Question: Looking at the figure, what chart type is it?
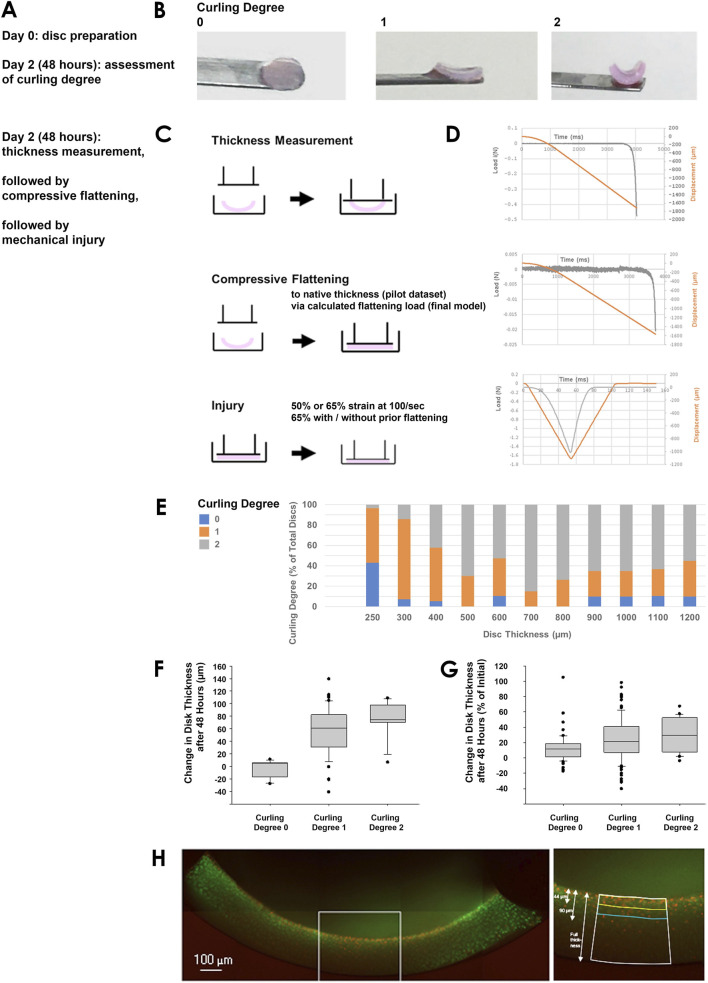
Answer: box